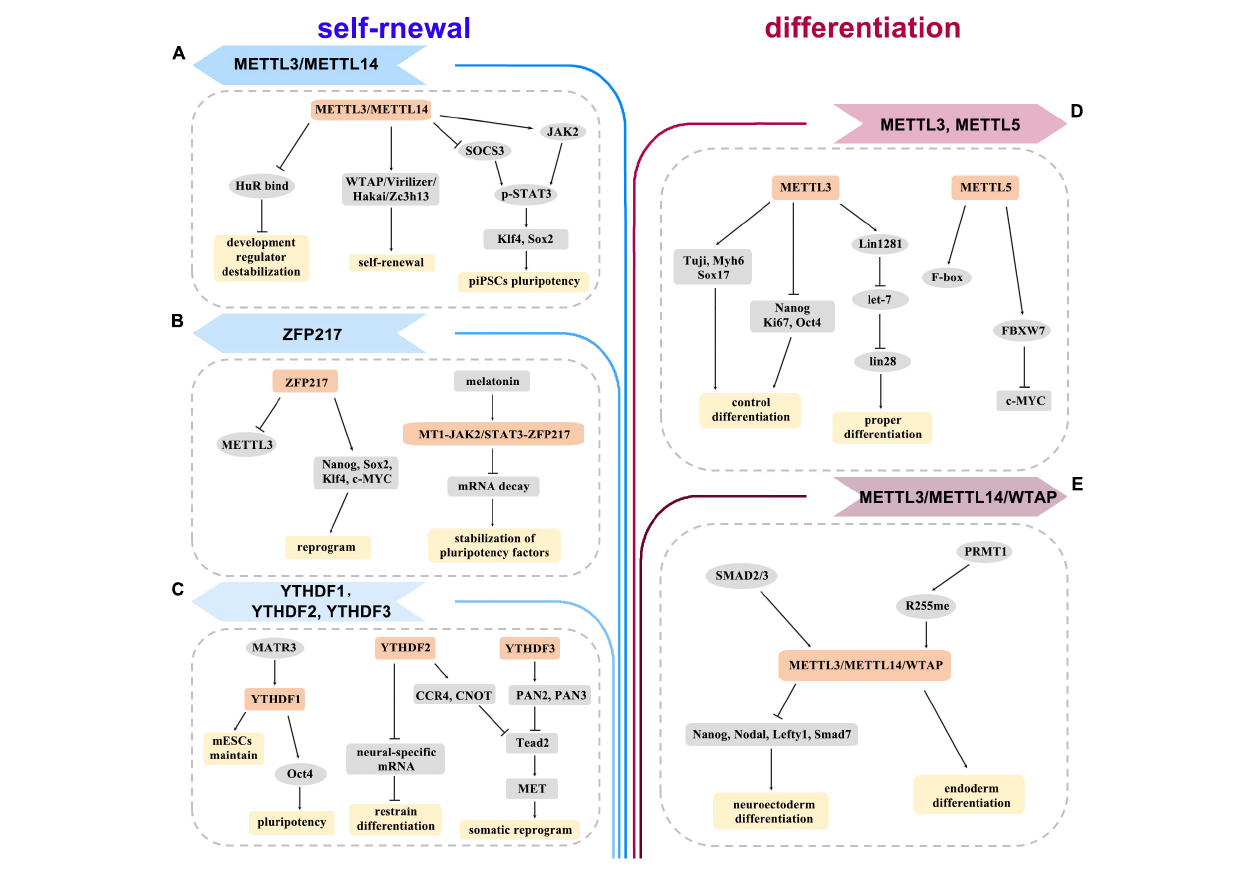
FIGURE 2 | The diagram depicts the roles of m 6 A methylation in self-renewal (A–C) and differentiation (D,E) of embryonic stem cells (ESCs) and induced pluripotent stem cells (iPSCs). It proposes how writers, erasers, readers, and other regulators are involved in the regulation of various genes and